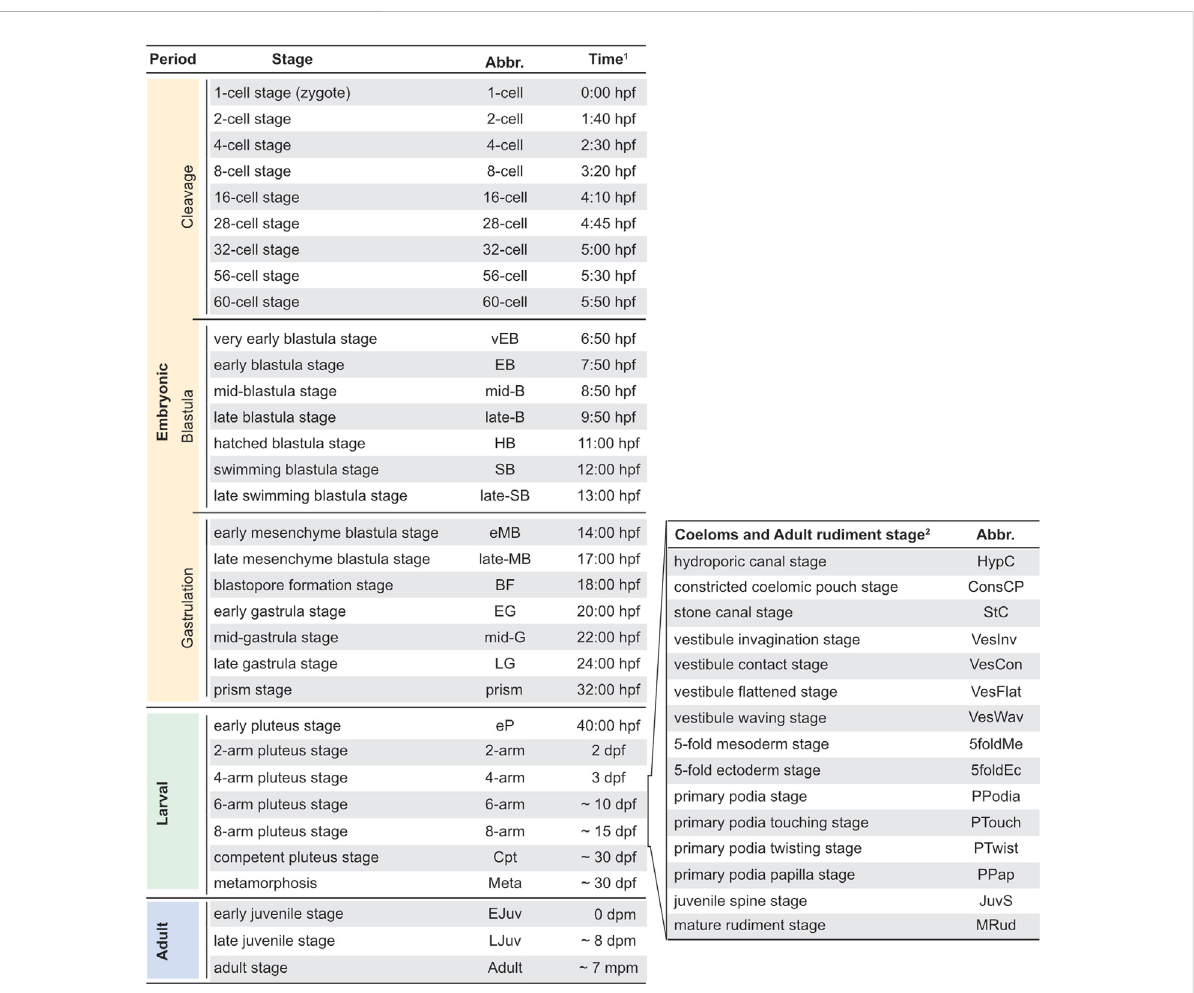
FIGURE 3 Paracentrotus lividus staging scheme. In the left panel, timing (1) is provided for our rearing conditions at 18 ° C. Note that a certain degree of heterochronywasobservedduringlarvalandadultperiods( (cid:1) ).Asdevelopmentofthecoelomsandtheadultrudimentproceededinparalleltothatof thelarva,duringthe4-,6-,and8-armpluteusstages,asubsectionforcoelomsandadultrudimentdevelopmentisprovidedintherightpanel. (2) Due to the heterochrony of the developmental trajectories of the coeloms and the adult rudiment, even within a given culture, a developmental timing for these events cannot be provided. Abbr.: abbreviation; dpf: days post-fertilization; dpm: days post-metamorphosis; hpf: hours post- fertilization; mpm: months